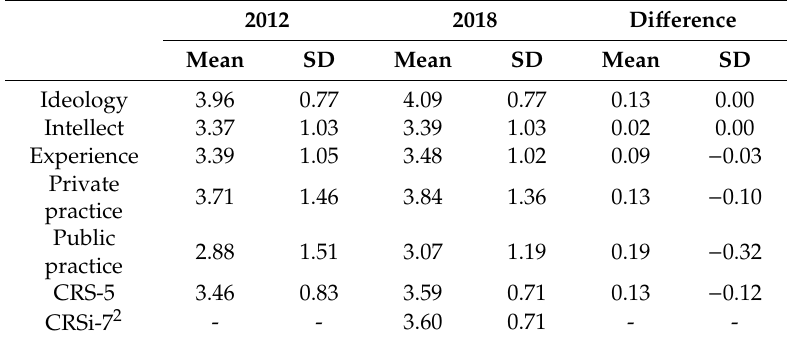
Table 3. Means and standard deviations and mean di ff erence between 2018 and 2012 of core dimensions of the CRS-5 and the CRSi-7 and the composite scores of the Christian orthodox samples in